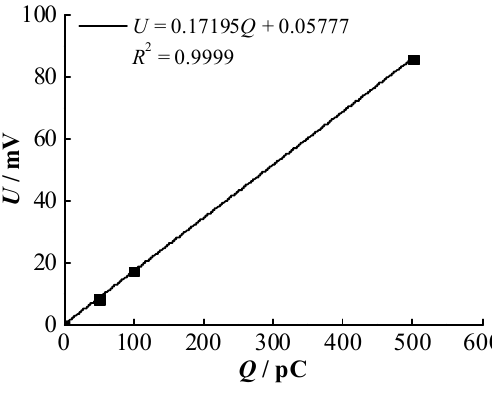
Figure 3. Calibration curve of PD magnitude.